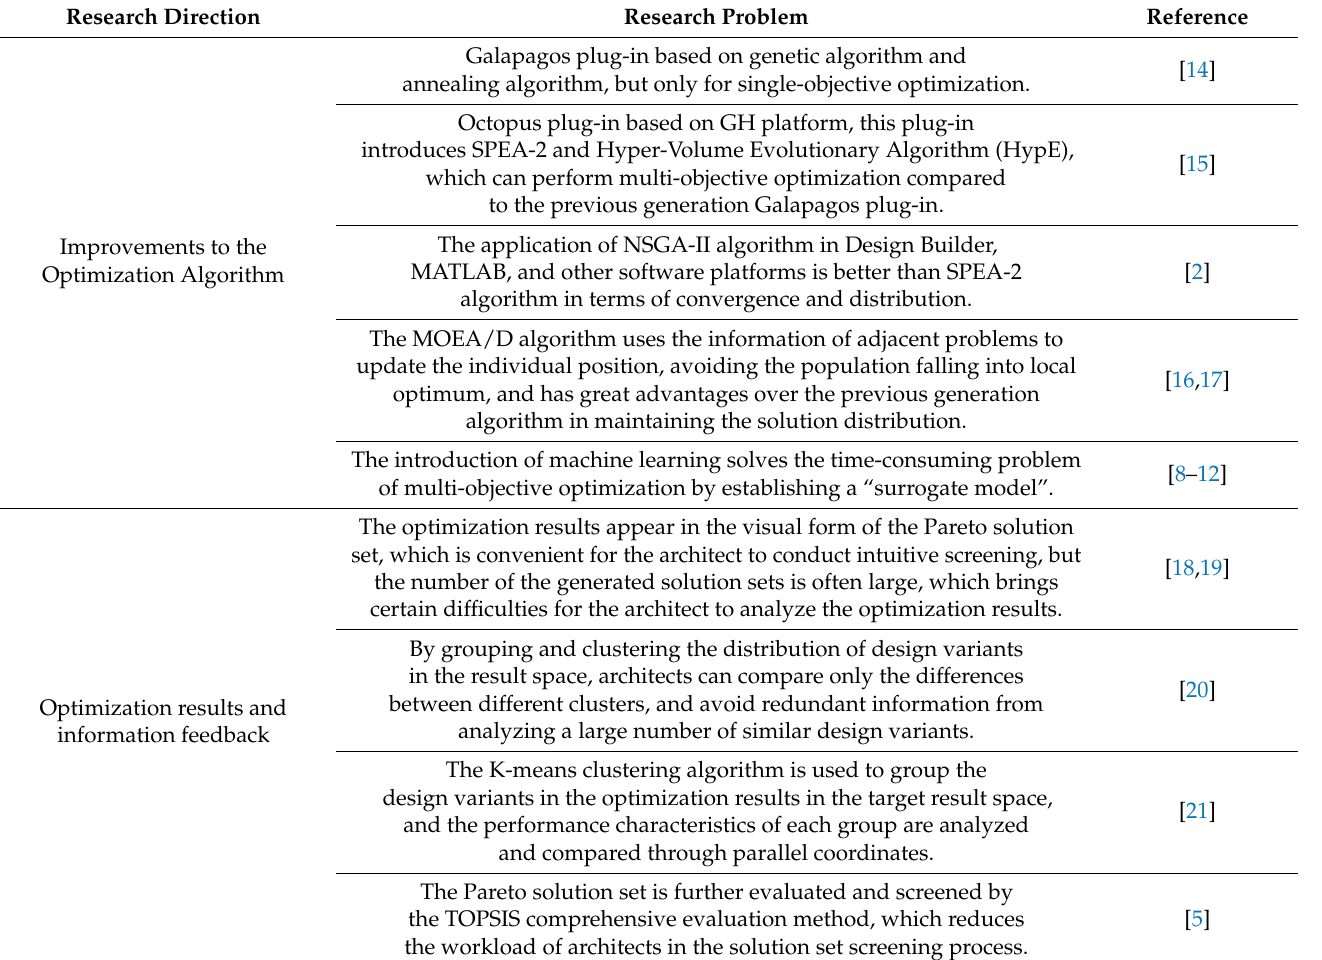
Table 1. The development of optimization algorithm research problems. Research Direction Research